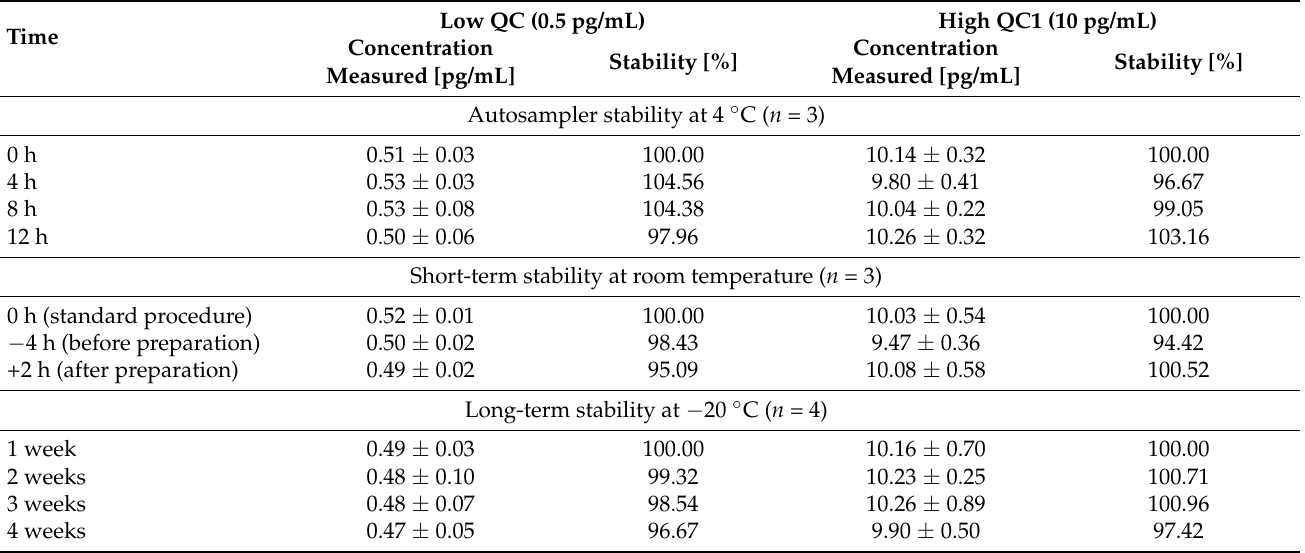
Table 2. Summary of TAC stability in ultrafiltrate under different conditions (autosampler, short-term, and long-term